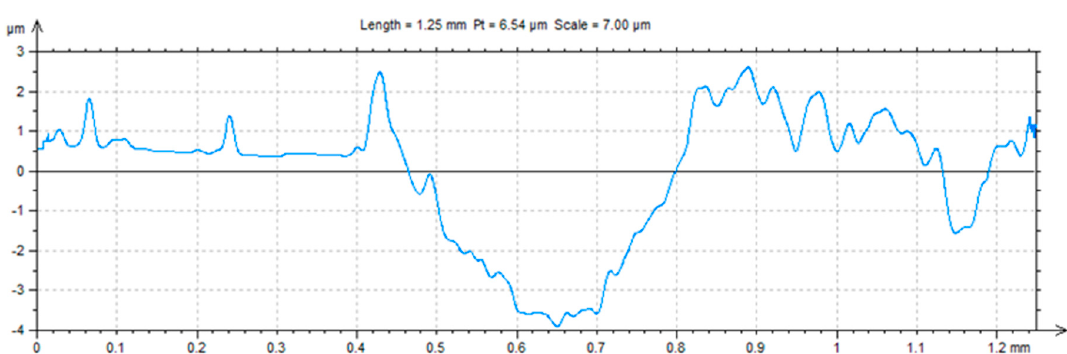
Figure 14. Trace after ball-on-plate test for material (Cu) after Ag alloying.